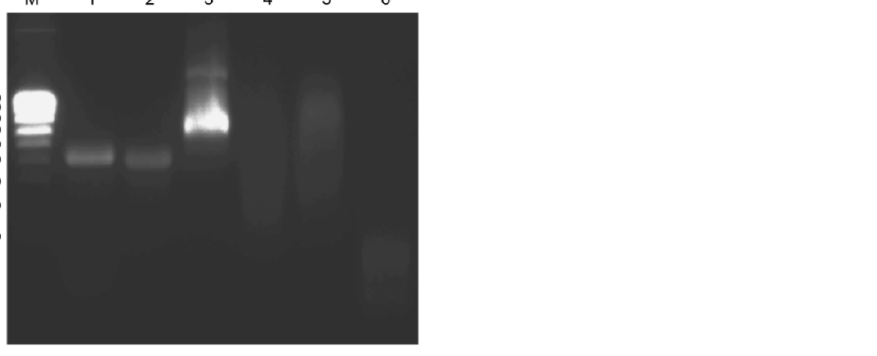
Figure 6. Delay of dsRNAs migration in 2% agarose gel electrophoresis when coated with increasing amounts of gCD ( A ) and sCD ( B ). (1) dsRNA; (2) gCD/sCD; (3) gCD/sCD:dsRNA [1:10]; (4) gCD/sCD:dsRNA [1:5]; (5) gCD/sCD:dsRNA [1:2.5]; (6) gCD/sCD:dsRNA [1:2]; (7) gCD/sCD:dsRNA [1:1]. ( C ) RNAse protection assays: (1) pristine dsRNA, (2) dsRNA and 0.125 U RNAse A 5 min, (3) gCD-dsRNA, (4) gCD-dsRNA and 1.25 U RNAse A 5 min, (5) gCD-dsRNA and 0.125 U RNAse A 5 min, (6) dsRNA and 1.125 RNAse A 5 min. M: NZY Tech Ladder V molecular weight marker.